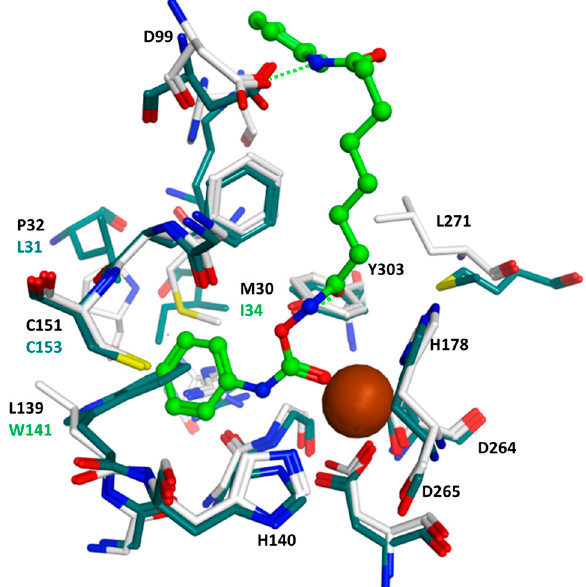
Figure 3. Comparison of the HDAC1- 2d docking complex (same colors as in Figure 2) and the HDAC8 crystal structure (PDB ID 2V5X, colored dark green). The residues of HDAC8 forming the foot pocket are labeled dark green.